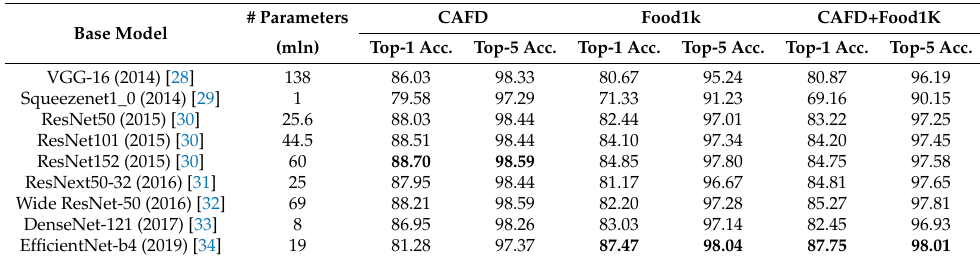
Table 3. Top-1 and Top-5 accuracies for different food classification models and datasets. Base